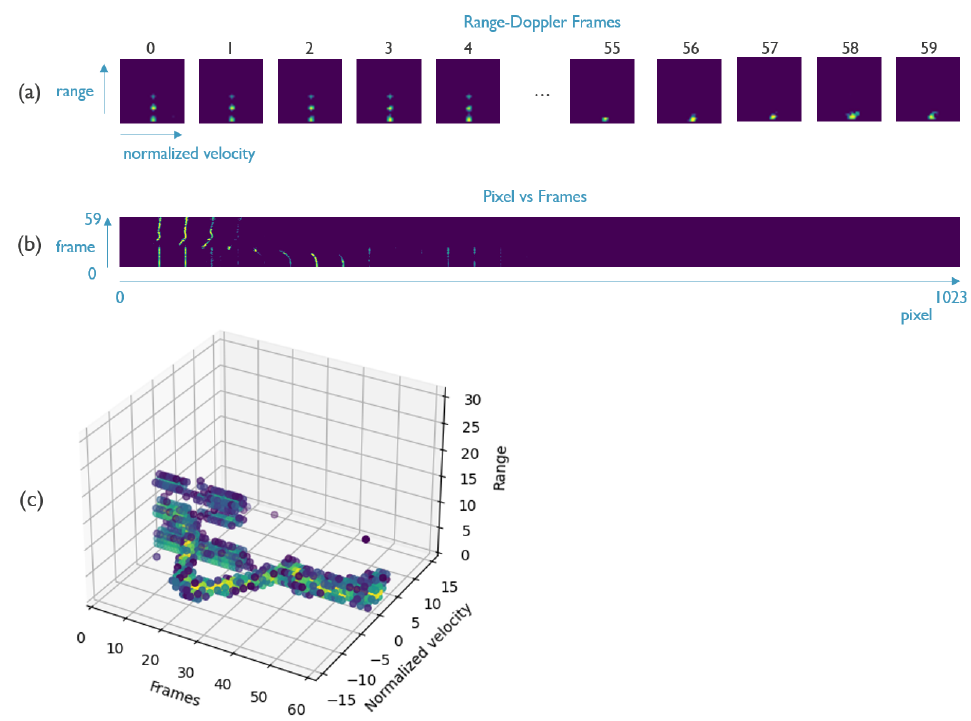
Figure 5. Soli Dataset: sample of the range-Doppler frames ( a ), the Doppler information is given as normalized velocity centered at zero. The pixel vs. frame image ( b ) shows the complete gesture capture of one receiver channel. Each frame was unrolled and stacked. For this particular sample, there are 60 frames. The number of frames varies with the time duration of each gesture sample. The 3D image of the range-Doppler frames ( c ) gives a visualization of the reflected radar signal in time, representing a push gesture movement (see Figure